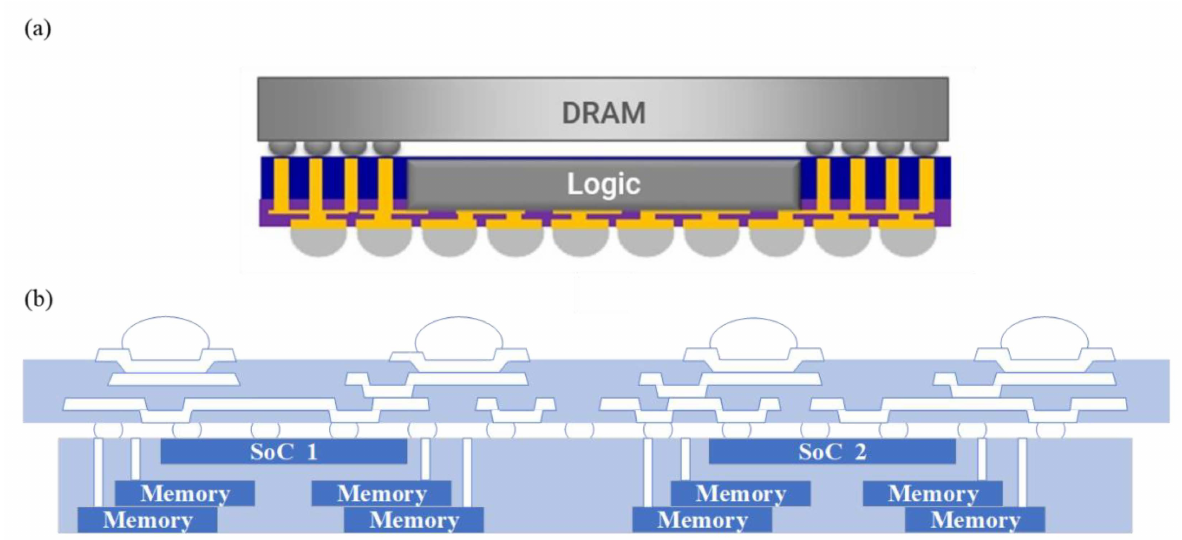
Figure 11. ( a ) Apple A10 chip package schematic (reprinted from Ref. [55], Copyright 2016, with per- mission from IEEE); ( b ) 3D-MiM (MUST-in-MUST) integration technology (reprinted from Ref. [57], Copyright 2019, with permission from